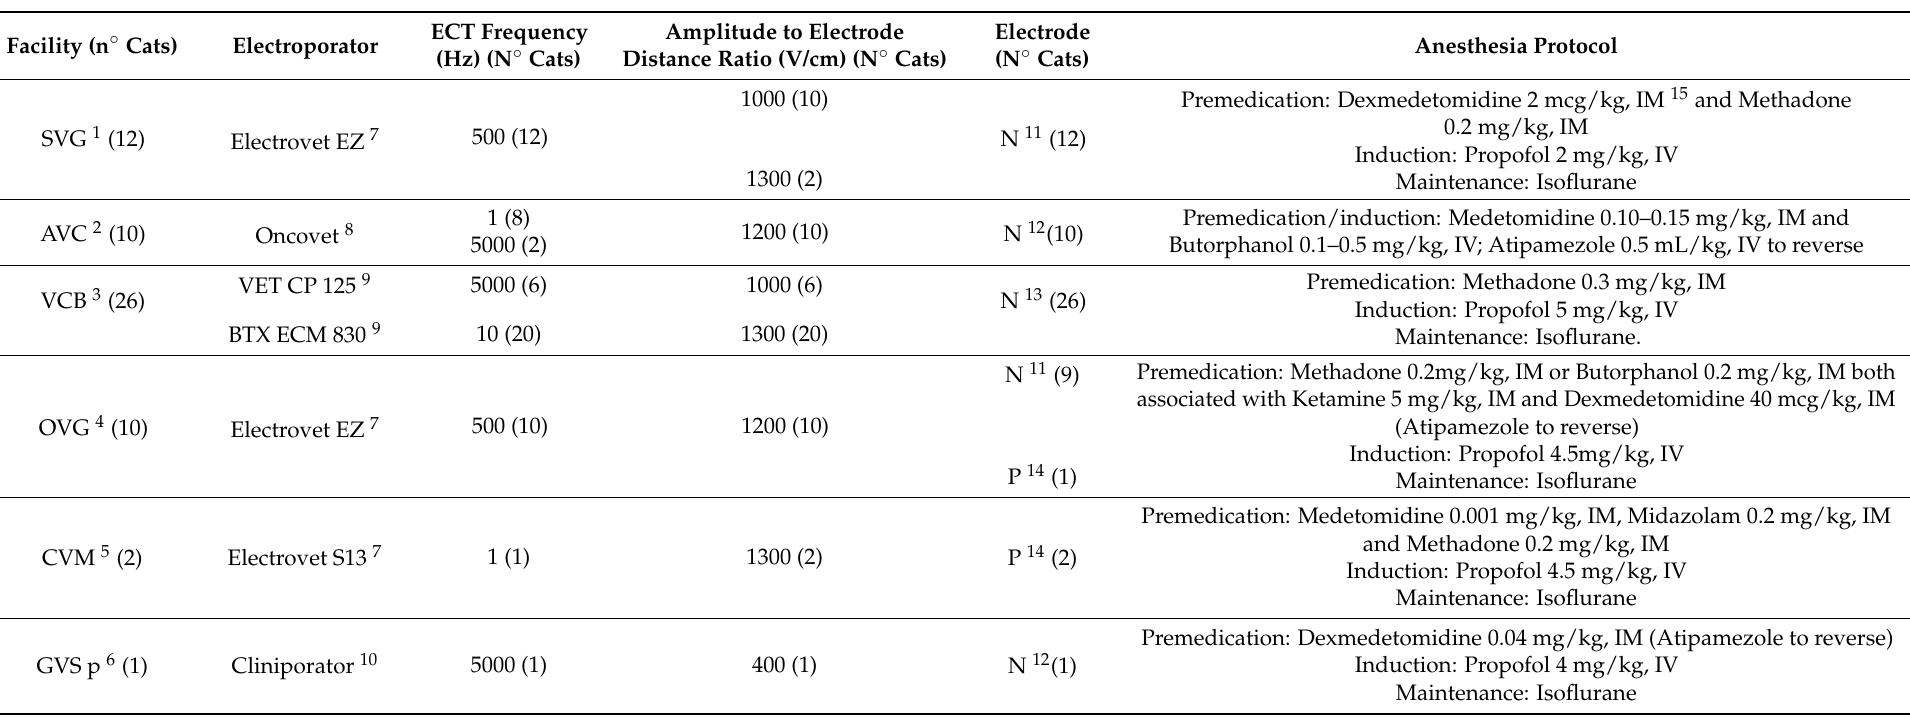
Table 1. Facility enrolled, electroporator type and its electrical characteristics, type of electrode and anesthesia protocol